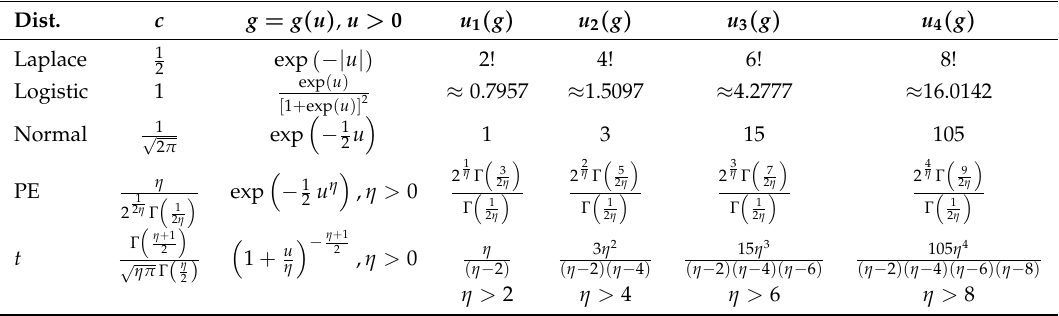
Table 1. Constants ( c and c g 2 ), density generators ( g ), and expressions of some moments u r ( g ) for the indicated